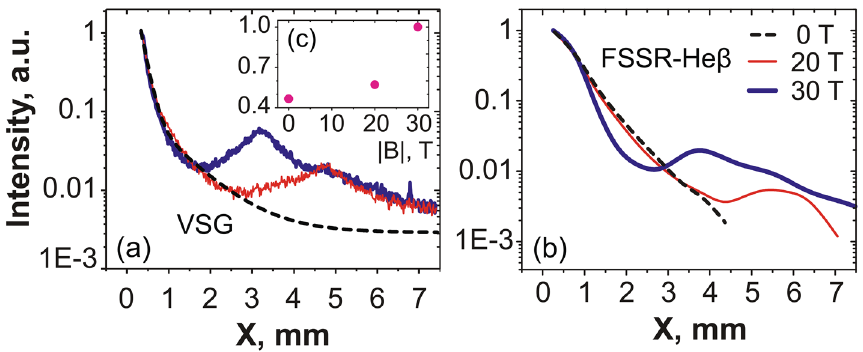
Figure 10. ( a ) Spatial profile of the emitted X-rays as recorded by the VSG and integrated over the 0.65–1 keV 10 12 W/cm 2 laser intensity on target. The plasma was immersed into the magnetic field spectral range, for a 2 × with strength of 30 T (blue), 20 T (red, thin) or expanded freely in vacuum (black dashed). ( b ) Same but for the He β spectral line measured by the FSSR spectrometer. ( c ) Evolution of the integrated plasma emission intensity 30 T), integrated in space and time, and deduced from the intensity profiles (normalized to its value at B = shown in ( a ), as a function of the B-field